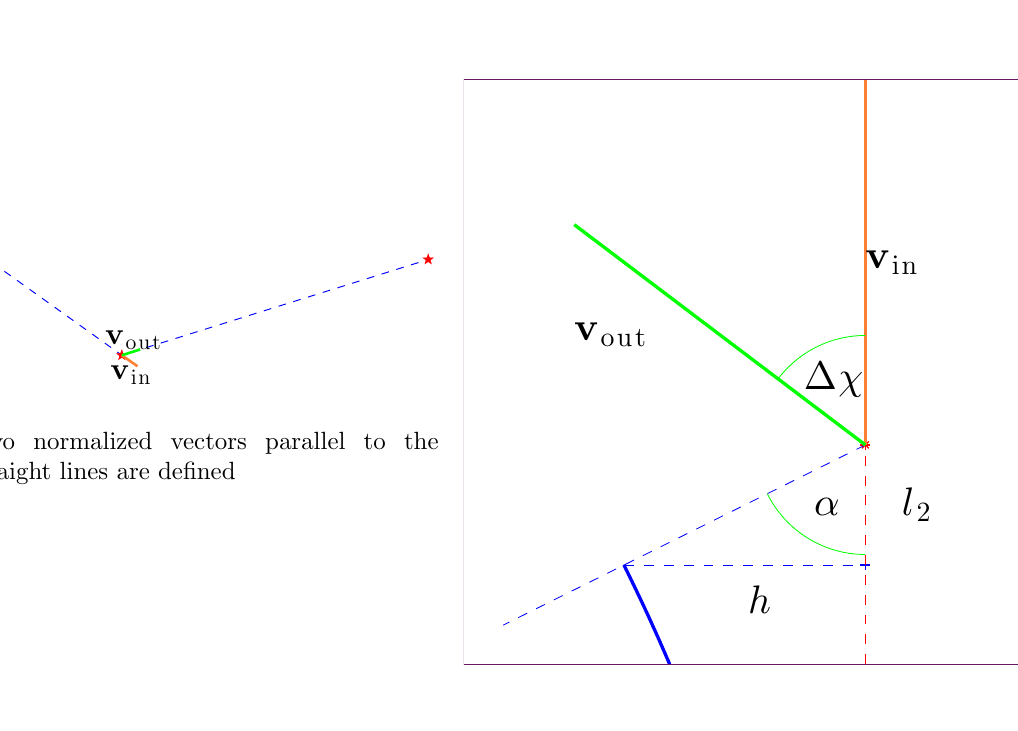
Figure 16: Starting point distance (magnified)